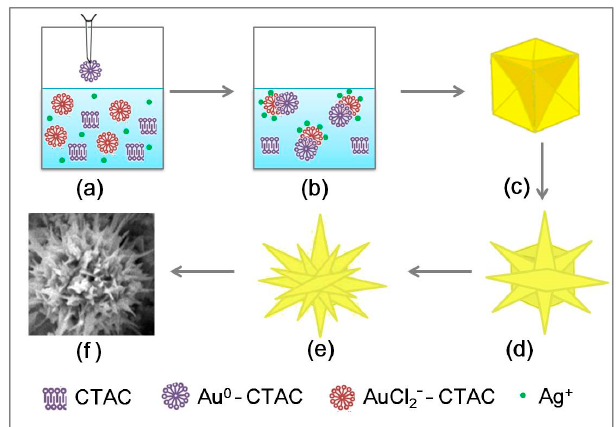
Figure 7. Schematic illustration for the formation of the chestnut-like Au nanocrystals. ( a ) The seeds were dropped into the growth solution. ( b ) AuCl 2 − complex was reduced onto the surface of Au 0 using electrons from ascorbic acid in the growth solution. ( c ) Formation of concave nanocubes during the initial growth period. ( d ) The radial growth of [111]-oriented nanoneedles. ( e ) The branched growth on the formed nanoneedles. ( f ) The chestnut-like Au nanocrystal.